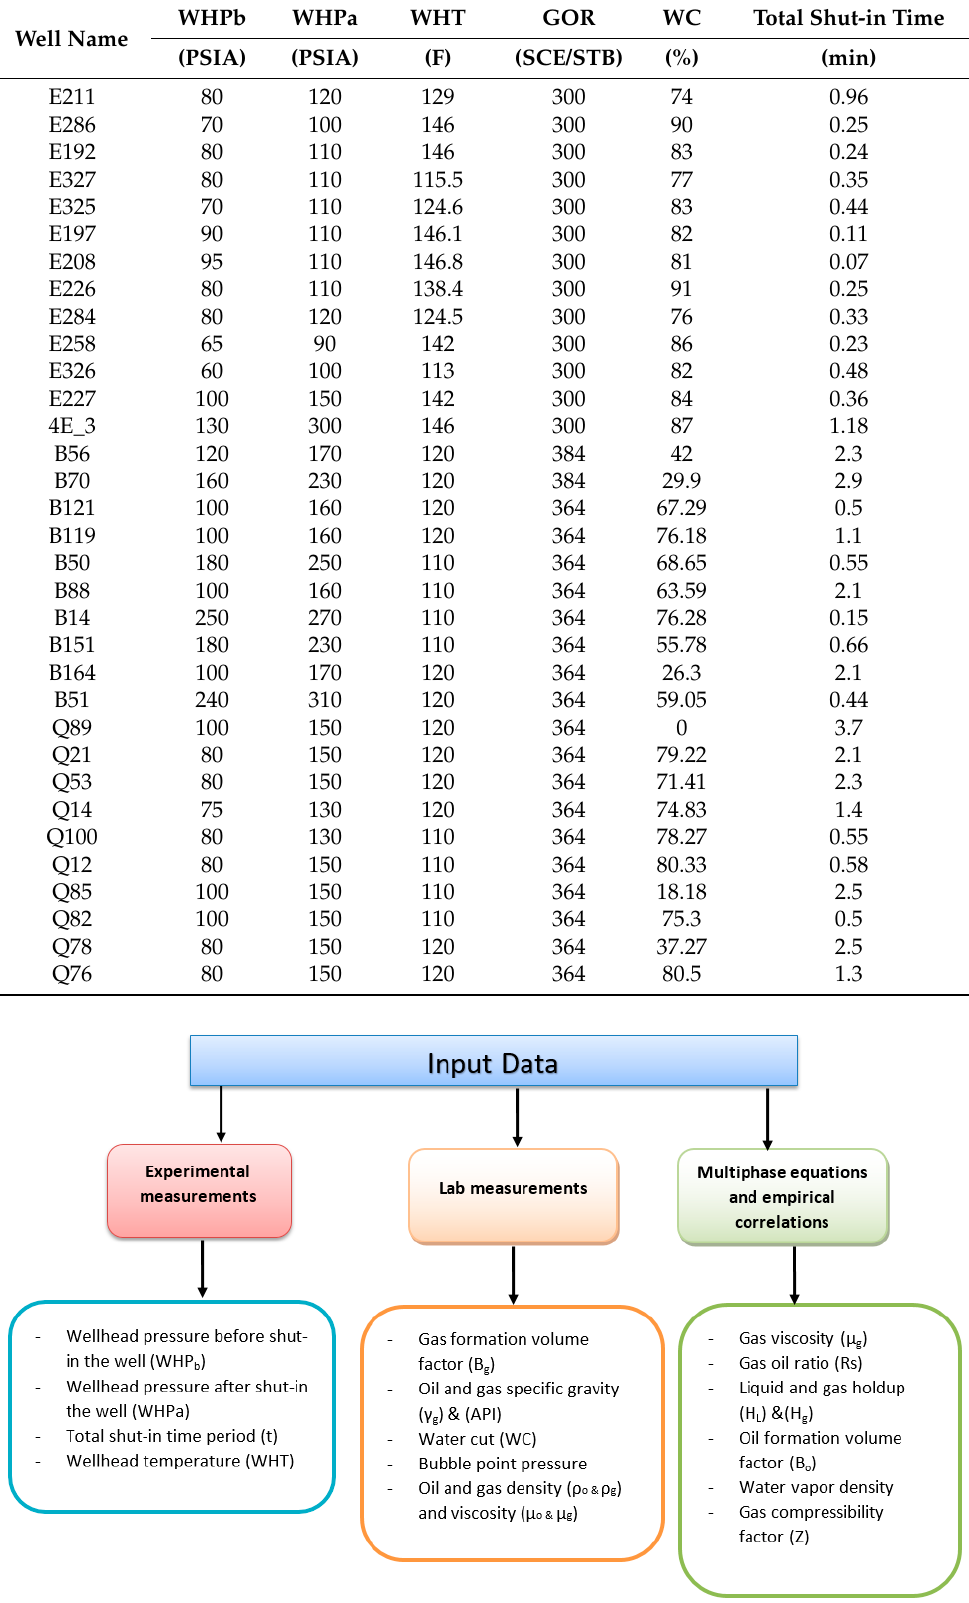
Figure 3. Input data required.